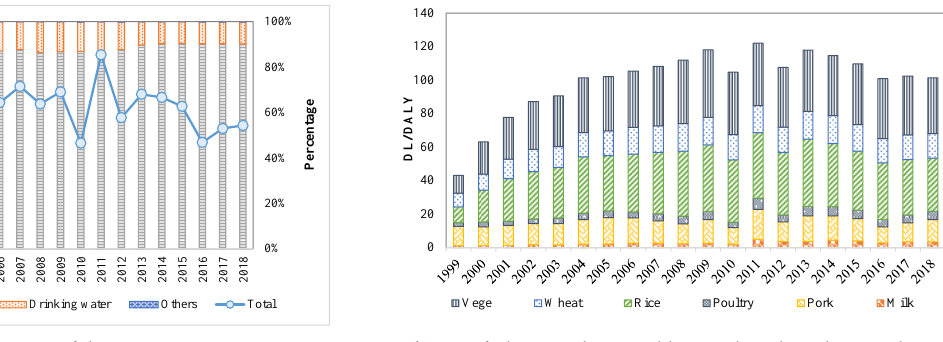
Figure 4. Contribution proportion of various intake exposure routes (( a )depicts the contribution proportion of dominant exposure routes of aquatic products, drinking water, and other exposure routes to total DL, and ( b ) depicts the contribution DL of exposures of other intake exposure routes of vegetables, wheat, rice, poultry, pork and milk).